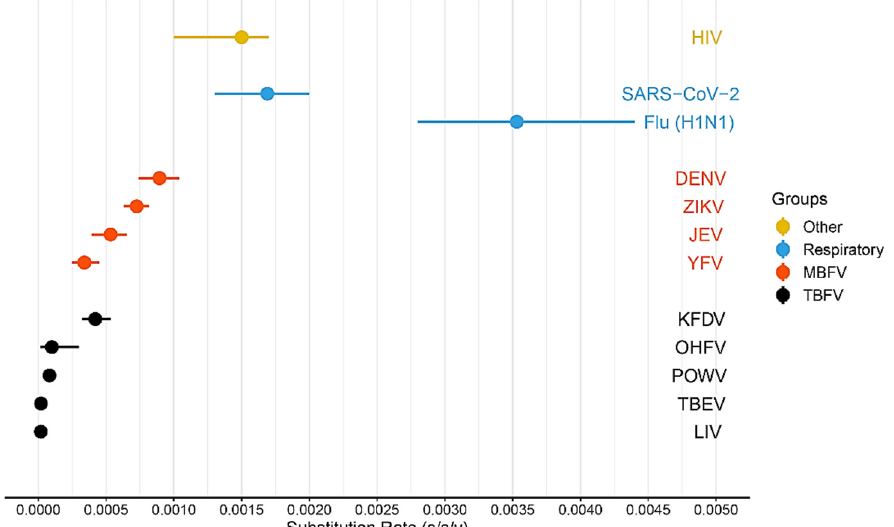
Figure 7. Nucleotide substitution rate comparison of tick-borne flaviviruses (TBFV), mosquito-borne flaviviruses (MBFV), respiratory viruses and HIV. Abbreviations: LIV—louping-ill virus, TBEV—tick-borne encephalitis virus, POWV—Powassan virus, OHFV—Omsk hemorrhagic fever virus, KFDV—Kyasanur Forest disease virus, YFV—yellow fever virus, JEV—Japanese encephalitis virus, ZIKV—Zika virus, DENV—dengue virus. The filled circles are median values, the horizontal bars are 95% highest posterior density (HPD) intervals.